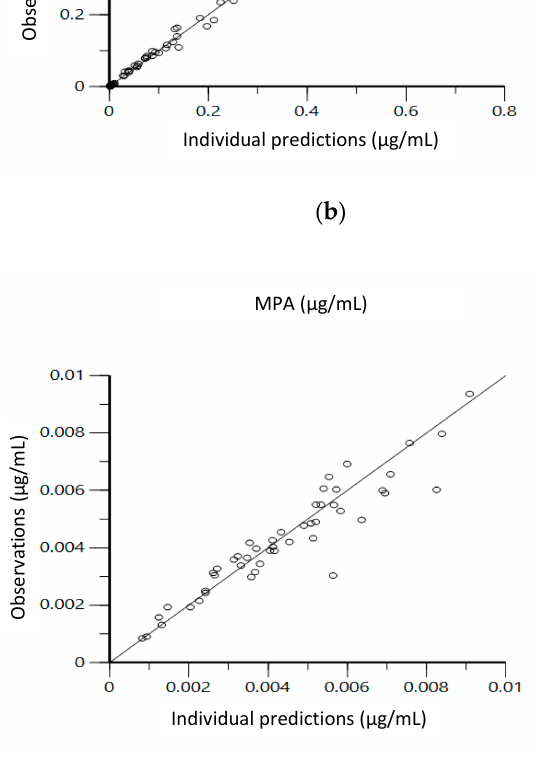
Figure 3. Goodness-of-fit plots showing observed vs. individual predicted mycophenolic acid plasma concentrations: ( a ) IV; ( b ) oral; ( c ) supralingual.